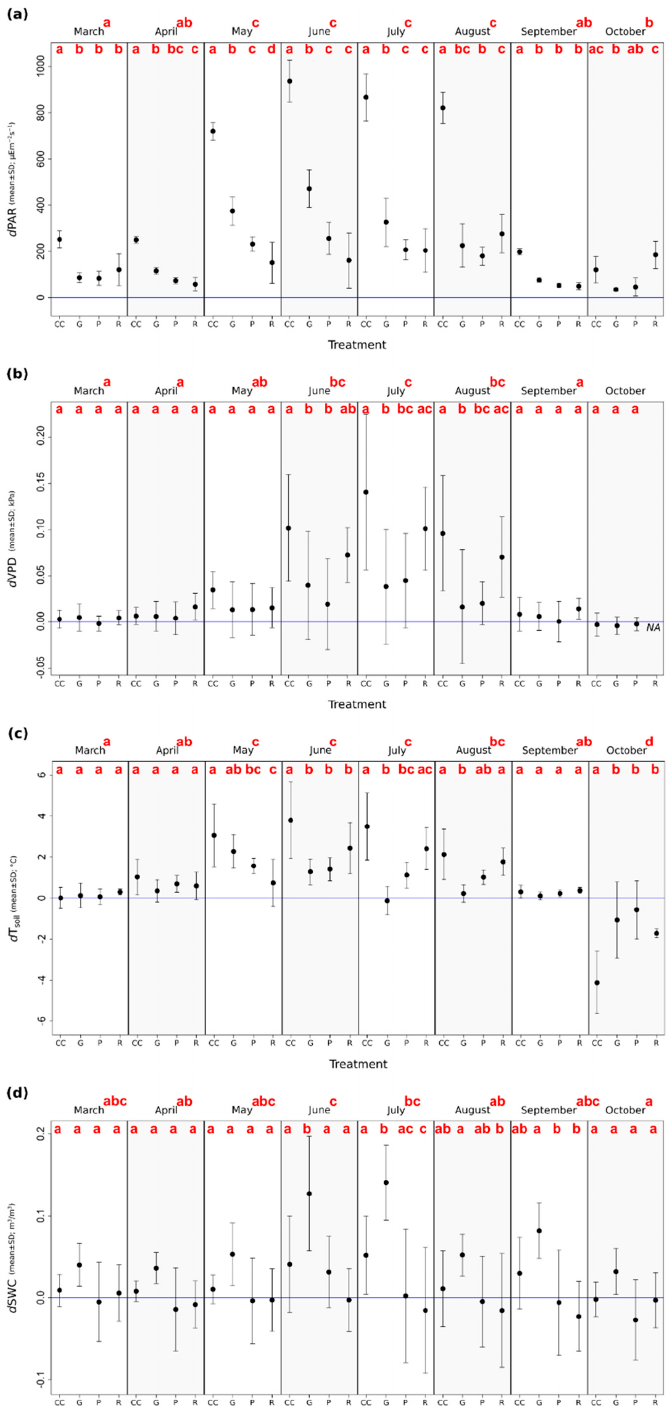
Figure 3. Temporal variability of the selected microclimate variables among the experimental treatments and months in the Pilis Mountains, Hungary, 2015. ( a ) Mean of the photosynthetically active radiation ([PAR] µ E m − 2 s − 1 ); ( b ) mean of vapor pressure deficit ([VPD] kPa); ( c ) mean of soil temperature ([T soil ] ◦ C); ( d ) mean of soil moisture ([SWC] m 3 /m 3 ). The letter d in the variable abbreviations refers to the differences from the mean values measured in the control plots. Treatment types are coded as follows: CC—clear-cutting; G—gap-cutting; P—preparation cutting; R—retention tree group. Full circles show the mean and vertical lines denote the standard deviation of the samples. Letters designate the significant differences among the treatments and months (all of the pairwise multiple comparisons based on the linear mixed effects models: Tukey test, alpha = 0.05). The horizontal blue line shows the level of the